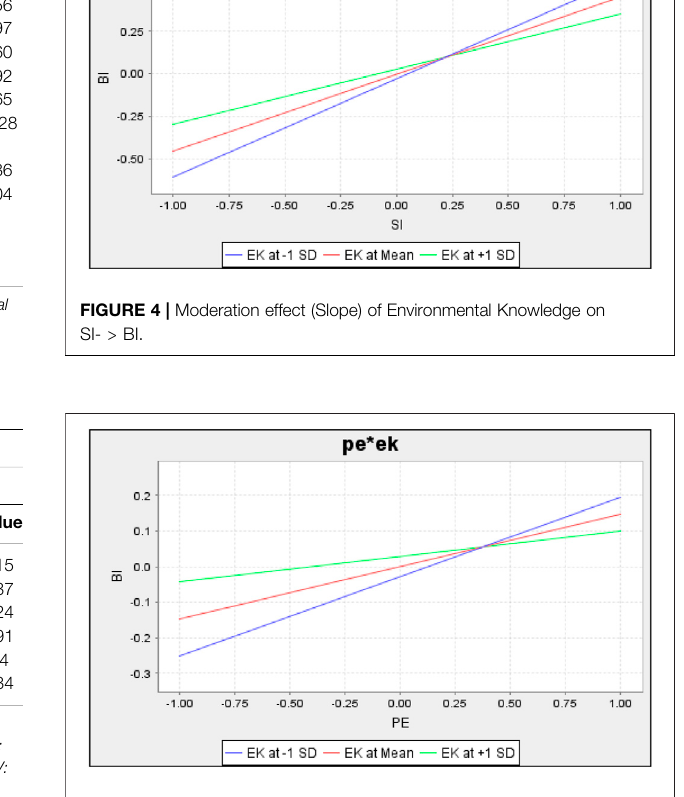
FIGURE 5 | Moderation effect (Slope) of Environmental Knowledge on PE- >